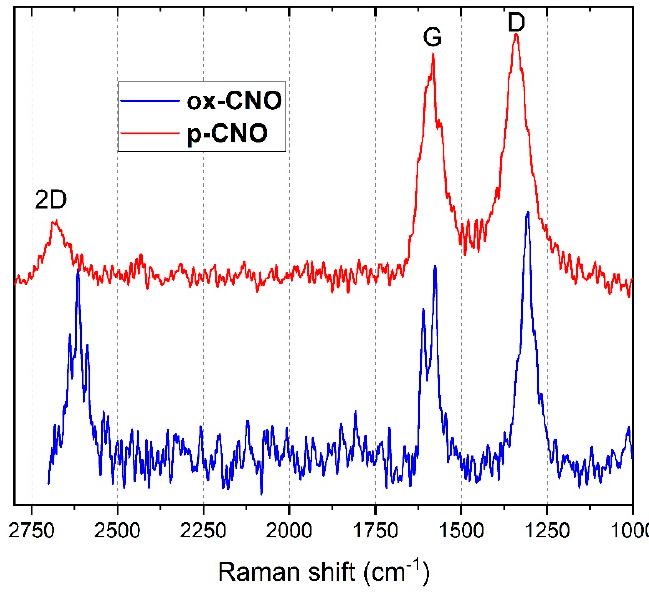
Figure 1. Raman spectrum of the oxidized carbon nano-onions (ox-CNOs) and pristine (p-)CNOs.